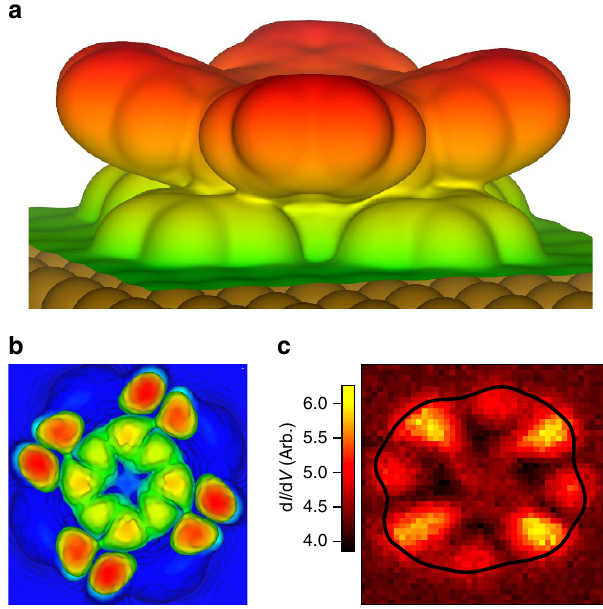
Figure 4 | Electronic asymmetry of due to surface interaction. ( a ) Isosurface of the total charge distribution of DyPc 2 /Cu(001) system. A coupling between the two Pc rings is observed only on one side of the arm. ( b ) Simulated STM image from (cid:3) 10 to 10mV. The asymmetry is clearly observed in the ligand states. ( c ) d I /d V slice at (cid:3) 3mV ( V set ¼ 70mV, I set ¼ 0.4nA), with the topographic outline of the molecule shown (black line). The close match between theoretical calculation and the d I /d V slice demonstrates the continuum of the Fano lineshape is due to the ligand states, and the 4 f Kondo is modulated through this. The outline of the molecule from the simultaneously taken topographic image is shown in